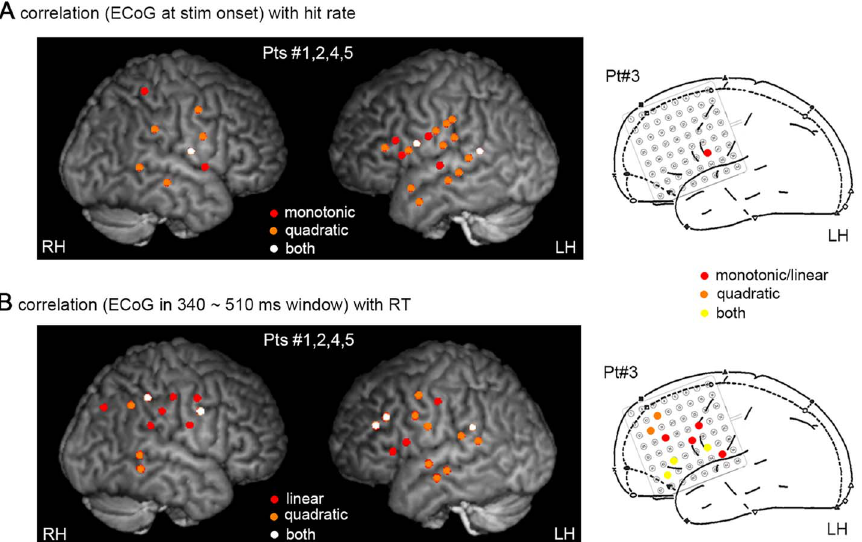
Figure 6. Electrode-by-electrode analysis (contralateral data). ( A ) Electrodes demonstrating a monotonic (red) or quadratic (orange) relationship (P , 0.05) between ECoG activity at stimulus onset and hit rate. Electrodes with both relationships are shown in white. ( B ) Electrodes demonstrating a linear (red) or quadratic (orange) relationship (P , 0.05) between ECoG activity around behavioral responses (averaged in a 340 , 510 ms post-stimulus window) and RT. Electrodes with both relationships are shown in white for Pts # 1,2,4,5 (left) and yellow for Pt # 3 (right). Because CT data was not available for Pt # 3, precise electrode localization could not be performed and presurgical planning diagram was used instead. LH: left hemisphere; RH: right hemisphere.